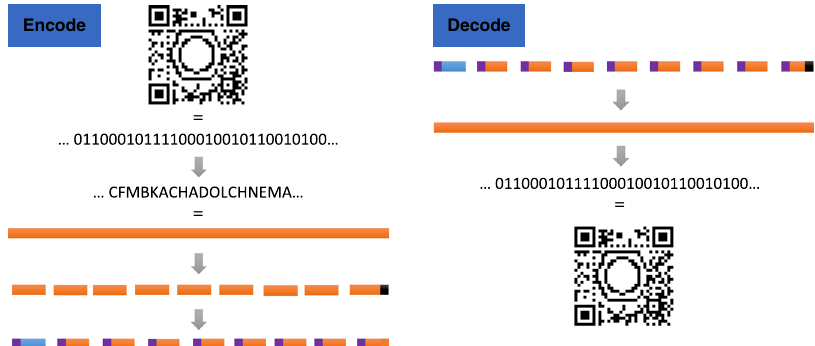
Fig. 4 Encoding and decoding of the QR code. Encoding scheme (left). The bit string representing the QR code is fi rst translated into a pentadecimal numeral system (base-20). The sequence of ‘ fl ags ’ is then cut into smaller pieces. In a fi nal step, the position of each fragment (purple) and the length of the bit string (blue) is added. The last fragment may be fi lled with a non-coding spacer (black); Decoding scheme (right). After determination of the sequence of all fragments, they are dereplicated, sorted, trimmed and glued together. Finally, the sequence of fl ags is converted into the bit string that reconstructs the original